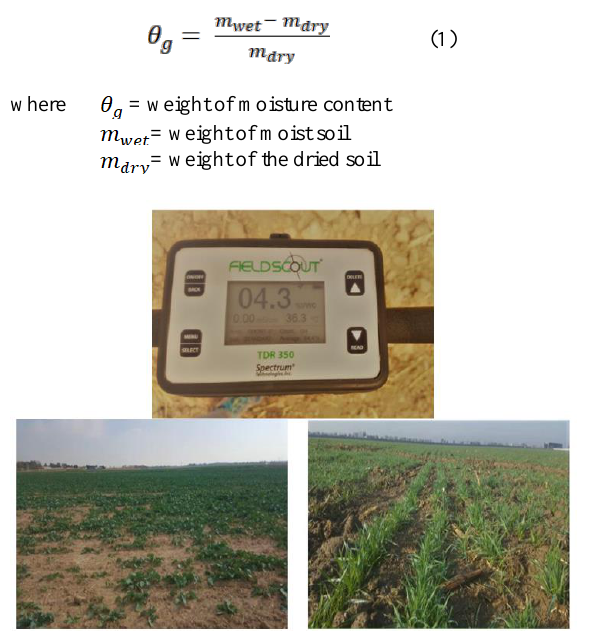
Figure 2. TDR-350 soil moisture probe and agricultural (canola (left) and winter wheat (right)) fields